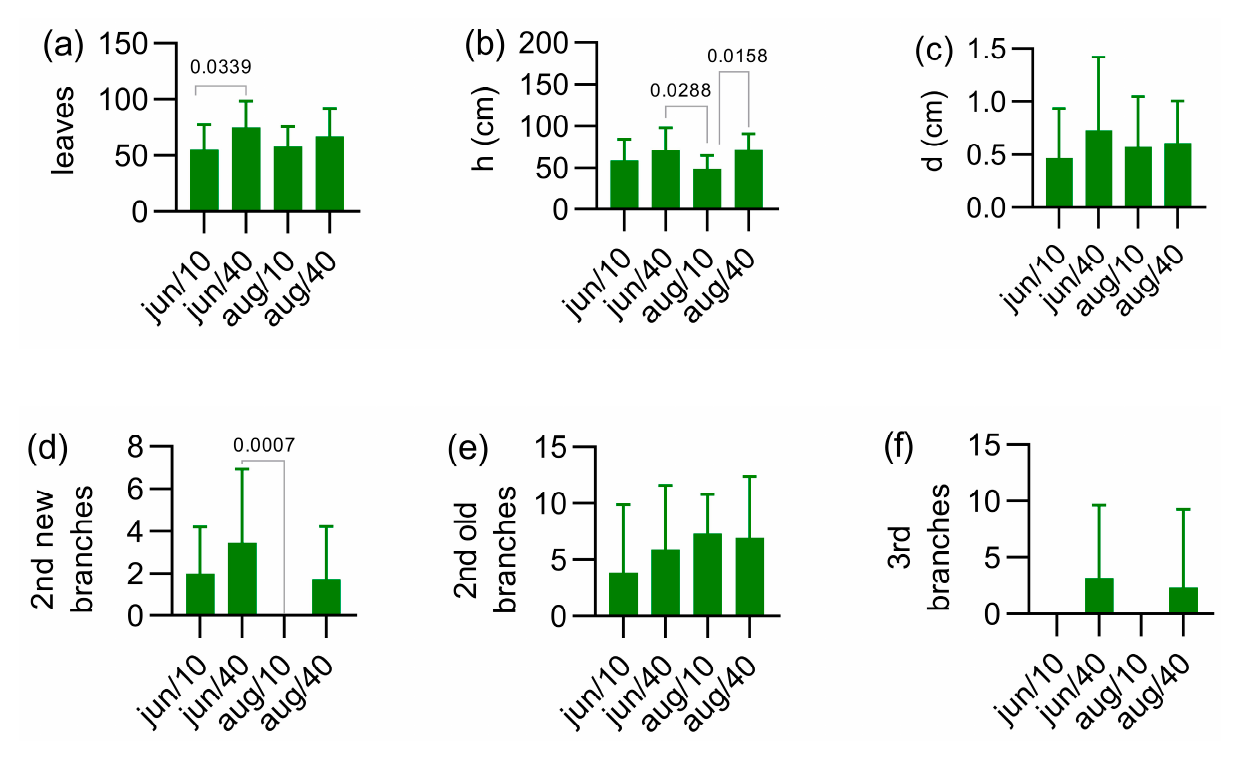
Figure 8. Effect of experimental conditions on the number of leaves ( a ), height of secondary branches ( b ), diameter of secondary branches ( c ), number of new secondary branches ( d ), number of old secondary branches ( e ) and number of tertiary branches ( f ). The data are represented as mean ± standard deviation of at least 80 measurements. In ( a , b ) ANOVA + Tukey’s test were used, and in ( d ) Kruskal–Wallis analysis + Dunn’s test were used. During this period the temperature was 20.44 ± 6.08 °C (37.8–4.2 °C) and the rainfall was 196 mm, according to data from a local meteorological monitoring service.